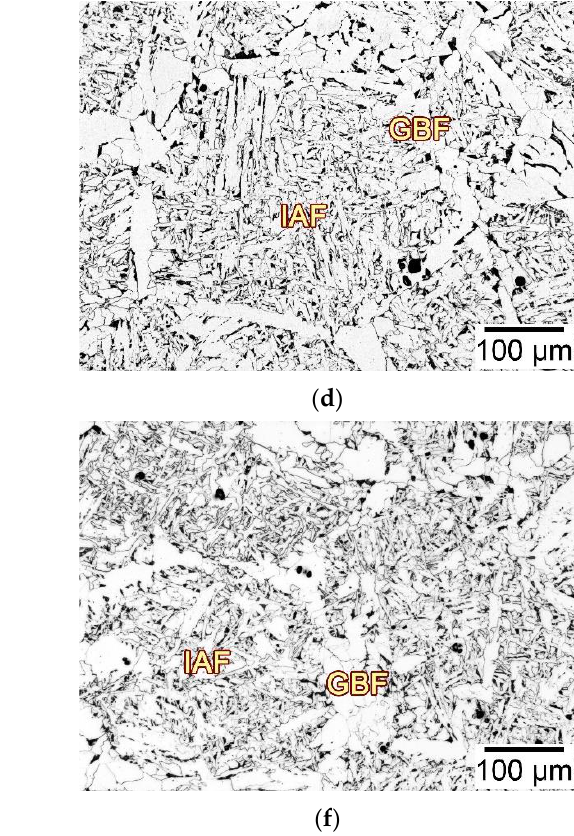
Figure 5. Optical images of the CGHAZ microstructures of ( a ) 2Ca, ( b ) 11Ca-1, ( c ) 11Ca-2, ( d ) 18Ca-1, ( e ) 18Ca-2 and ( f ) 25Ca steels after large-heat-input welding at 400 kJ cm − 1 .